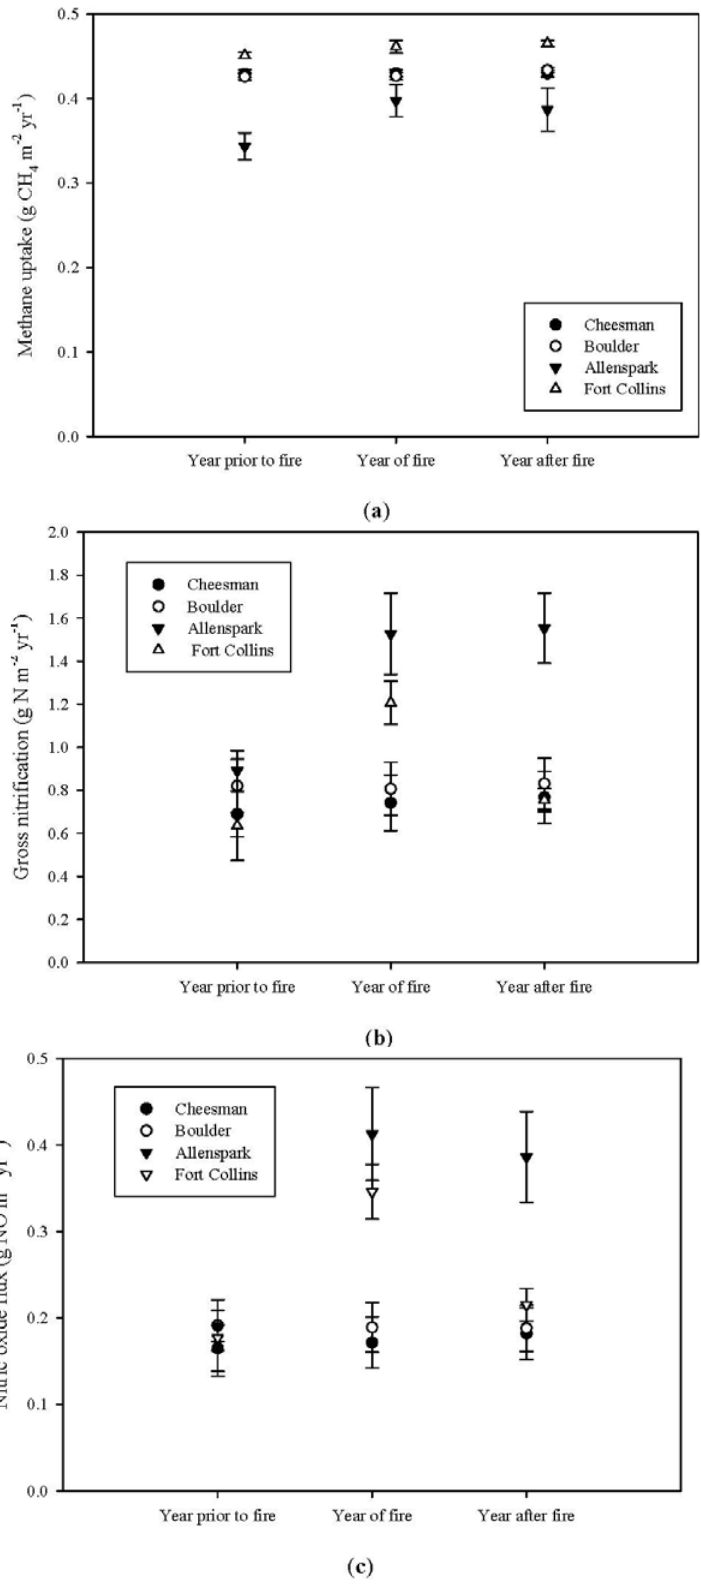
·m − 2 ·yr − 1 ); ( b ) gross nitrification (g·N·m − 2 ·yr − 1 ) Figure 2. ( a ) Methane uptake rates (g·CH 4 and ( c ) nitric oxide fluxes (g·NO·m − 2 ·yr − 1 ), for each of the four simulated locations. Points represent the means of methane uptake one year prior to, during the year of, and one year after a fire occurred for each site. Error bars are the standard error of the